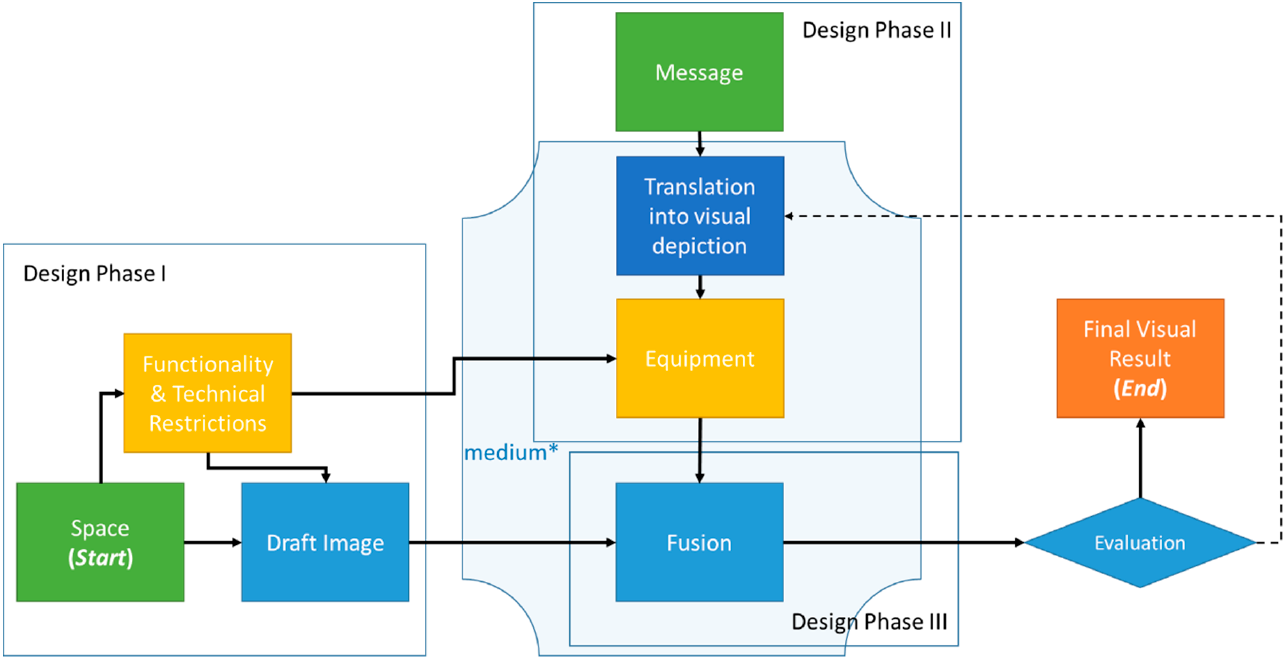
Figure 6. An attempt for a framework of design lighting towards eliminating iterative